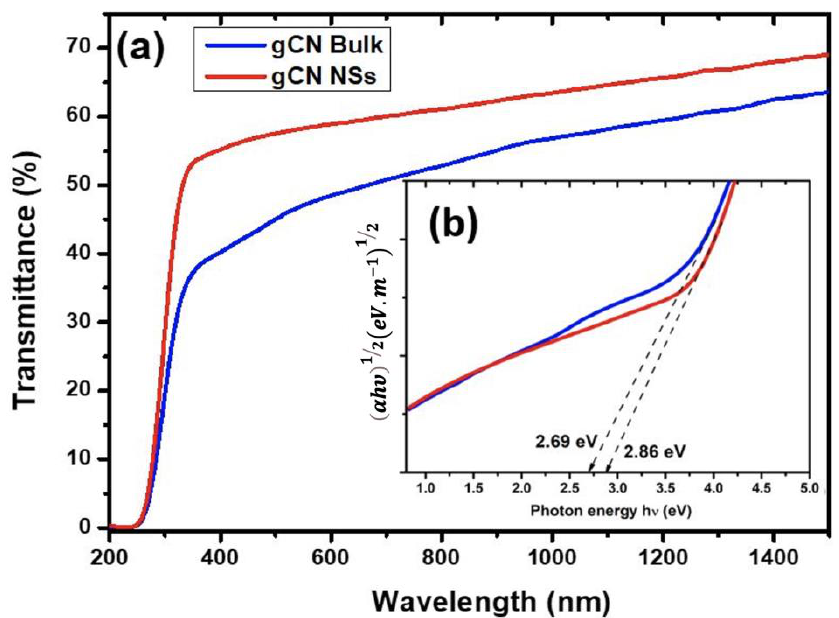
Figure 7. ( a ) Optical transmittance of both bulk and monolayer gCN, ( b ) ( αhν ) 1/2 vs. photon energy for gCN bulk and monolayer and their respective band gap energy.